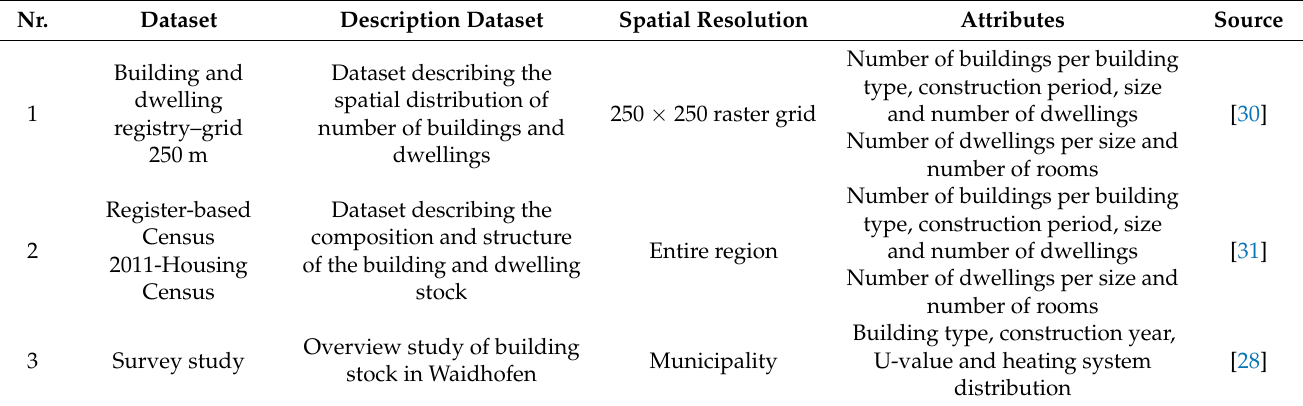
Table 2. Overview input data for